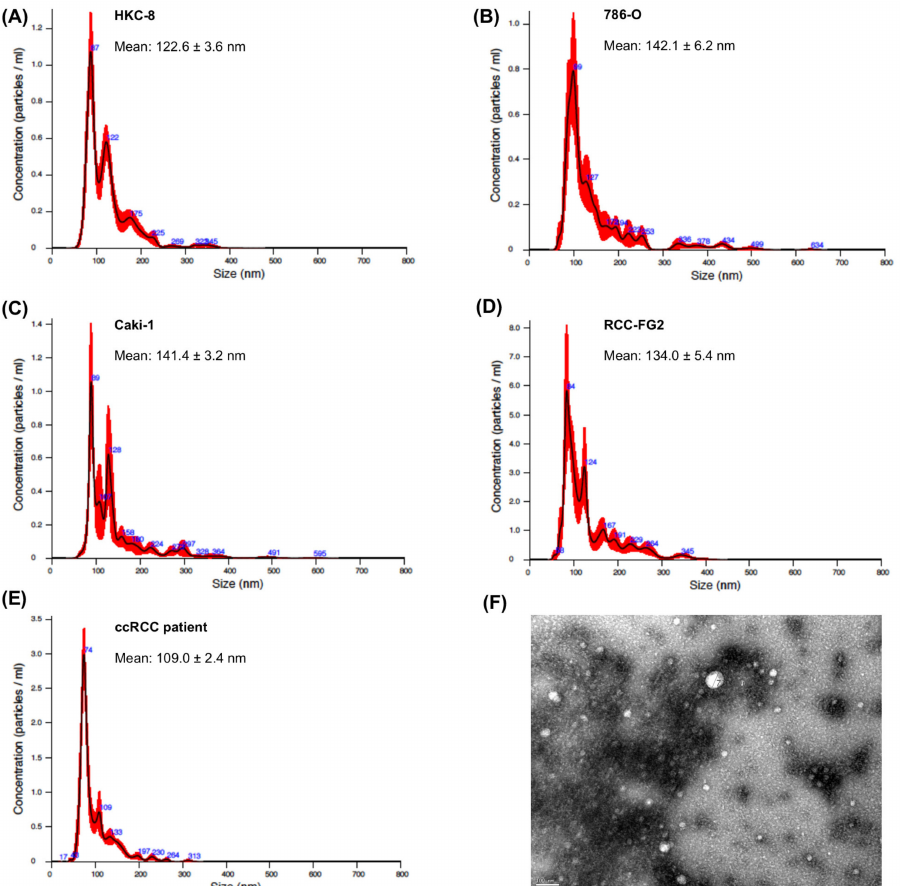
Figure 1. Nanoparticle tracking analysis (NTA) of extracellular vesicles (EVs) derived from ( A ) HKC-8, ( B ) 786-O, ( C ) Caki1 and ( D ) RCC-FG2 cells and ( E ) clear cell renal cell carcinoma (ccRCC) patients. The red error bars indicate ± 1 standard error of the mean. ( F ) Transmission electron microscopy (TEM) of EVs from purified platelet-free plasma (PFP). The TEM image was acquired in the Histology and Electron Microscopy platform from I3S Porto using a Transmission Electron Microscope Jeol JEM 1400.